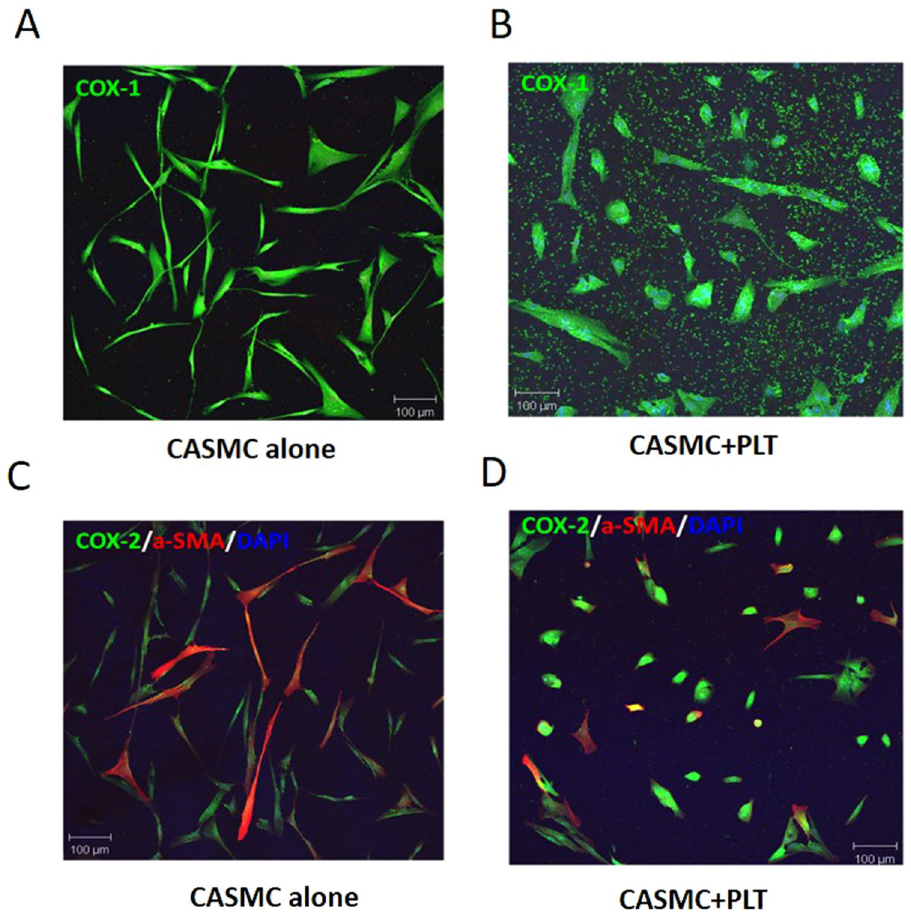
Figure 1. Effects of platelets on phenotypic modulation of CASMC. Human CASMC (0.8 × 10 5 cells) were cultured alone or cocultured with human platelets (0.5 × 10 8 ). COX-1 (green) ( A , B ) or COX-2 (green) and α-SMA (red) ( C , D ) expression was assessed by confocal microscopy. Image magnification was